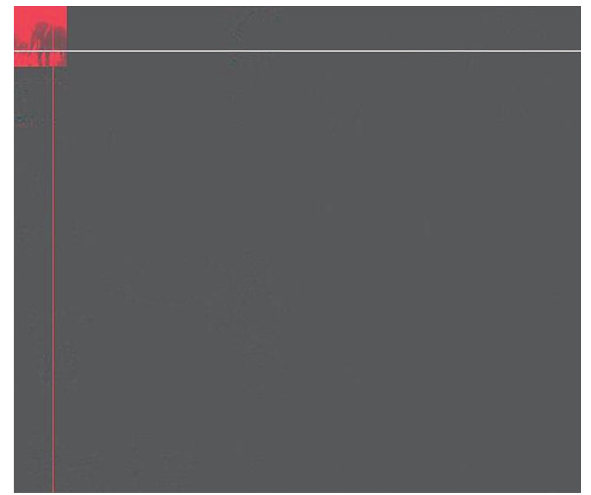
Figure 6: Downsampled decomposed elephant